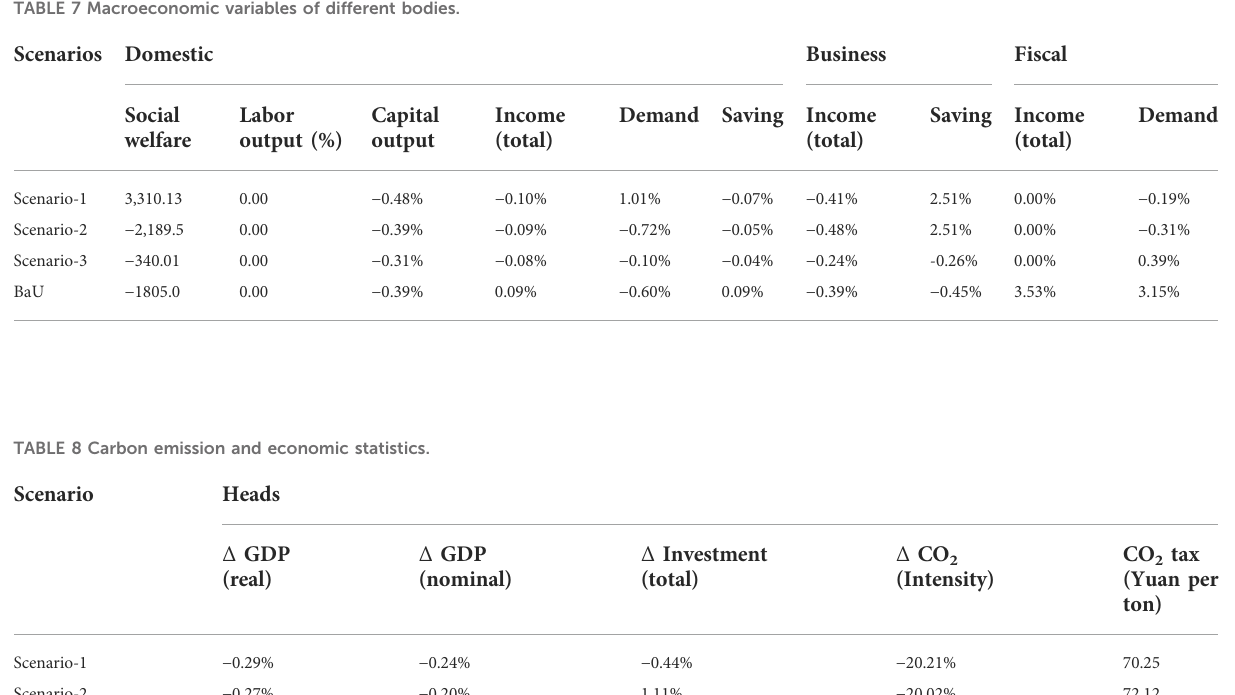
TABLE 7 Macroeconomic variables of different bodies.